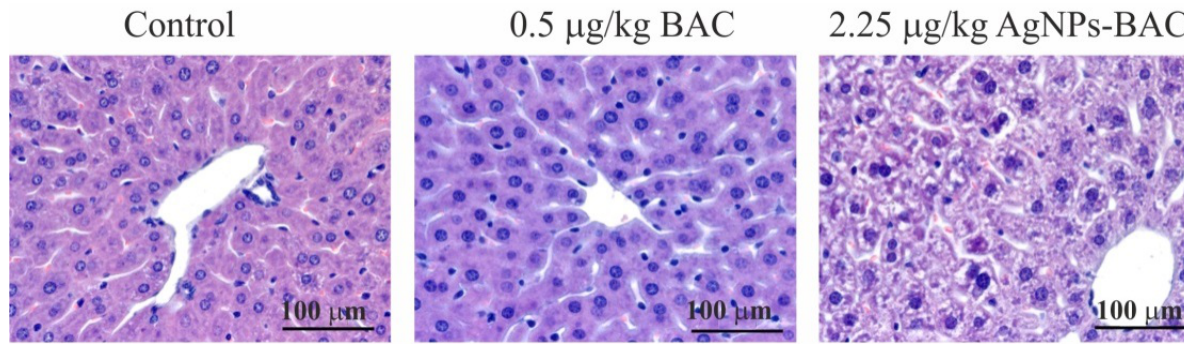
Figure 7. Jejunum histology section of the animals from the experimental and control groups. Hematoxylin-eosin staining, × 10 magnification. M—mitotic phase cells (in ana-, meta- and telophase), L—lymphocytes, G—goblet cells mucus.